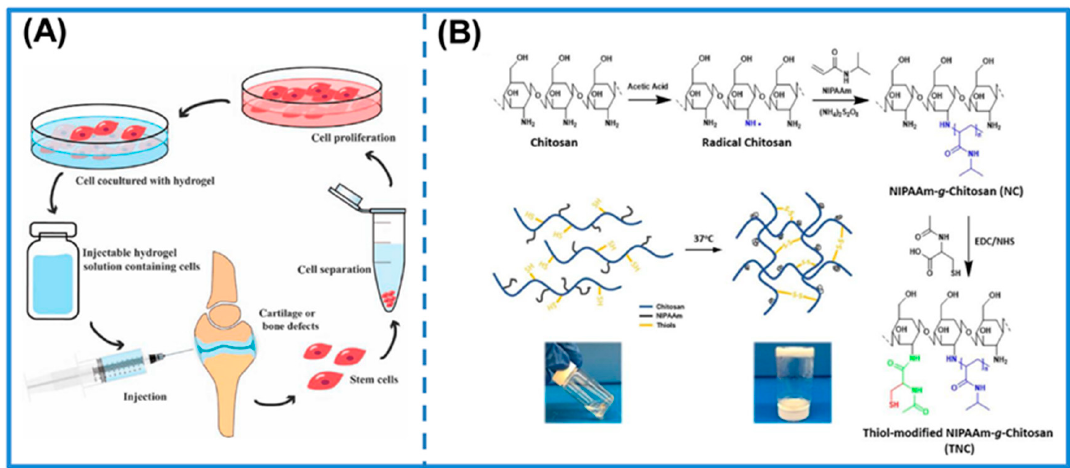
Figure 4. ( A ) Schematic illustration of approaches to make injectable hydrogels for cartilage- and